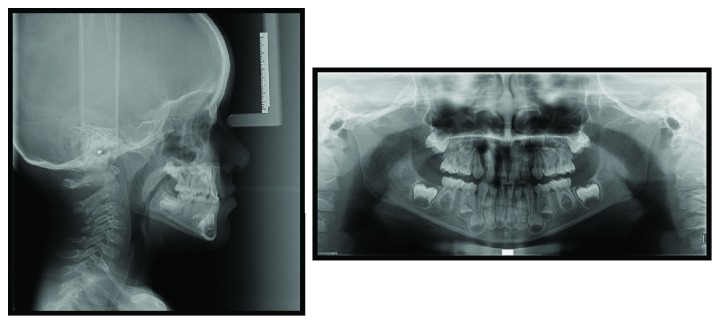
Extraoral X-rays.